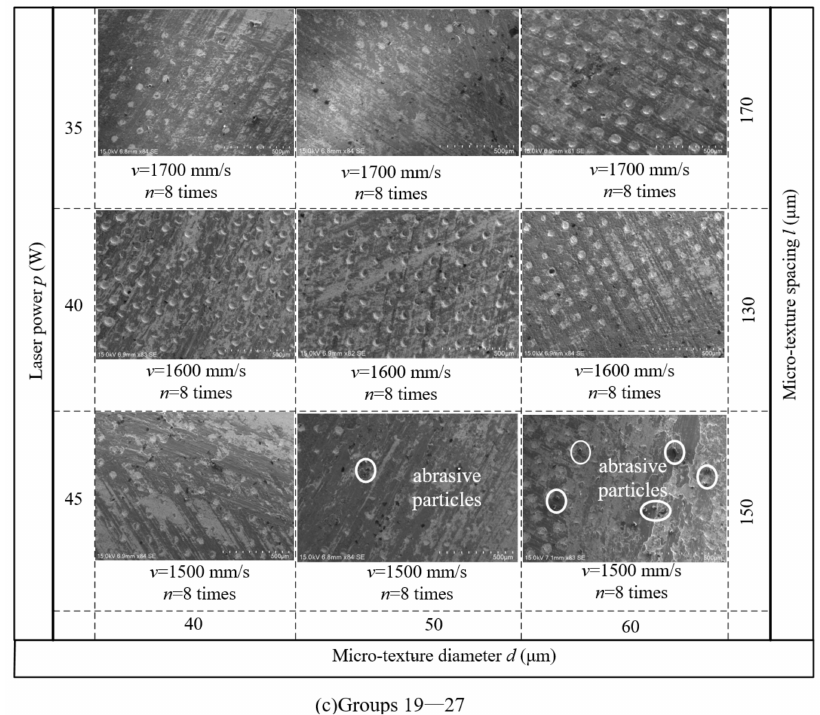
Figure 12. Micro-texture wear morphology. ( a ) is the friction and wear morphology of 1–9 groups of tests, ( b ) is the friction and wear morphology of 10–18 groups of tests, ( c ) is the friction and wear morphology of 19–27 groups of tests.